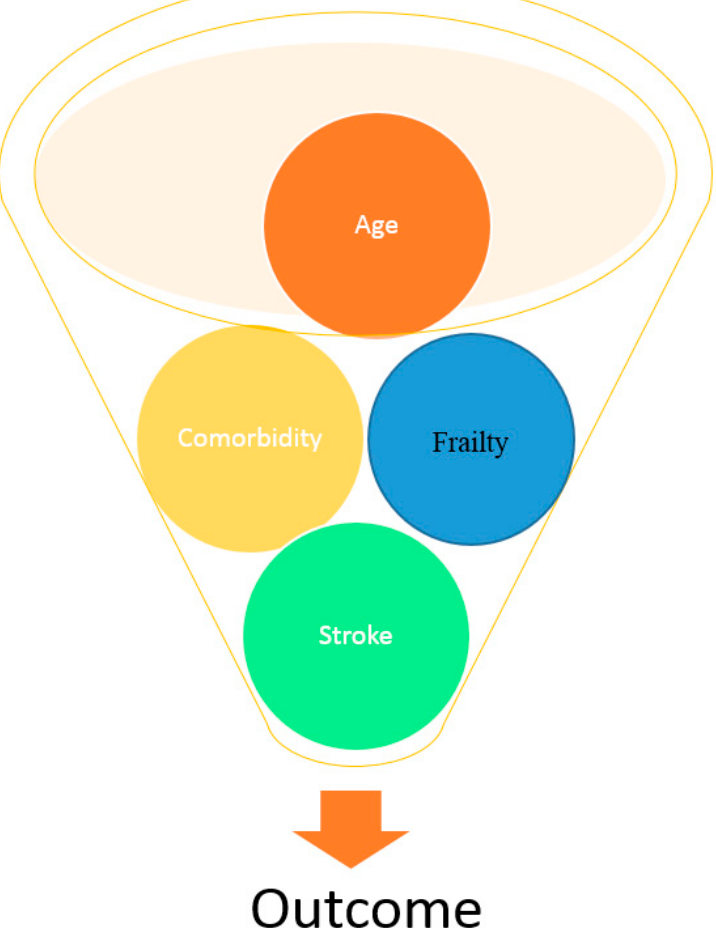
Figure 3. The interplay between age, frailty, comorbidity and stroke on outcome.